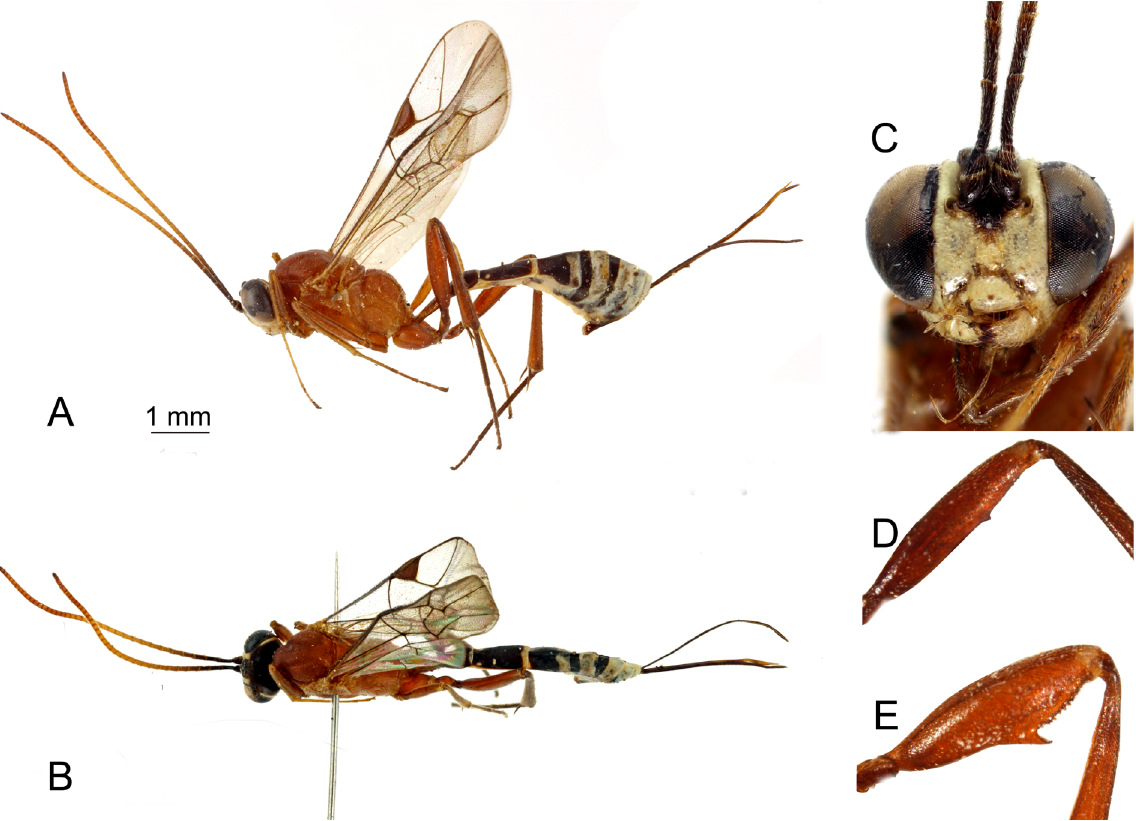
Fig. 6. Pristomerus guinness sp. nov. A . ♀, habitus, profile. B . ♀, habitus, dorsal. C . ♀, head, facial. D . ♀, hind femur, profile. E . ♂, hind femur,